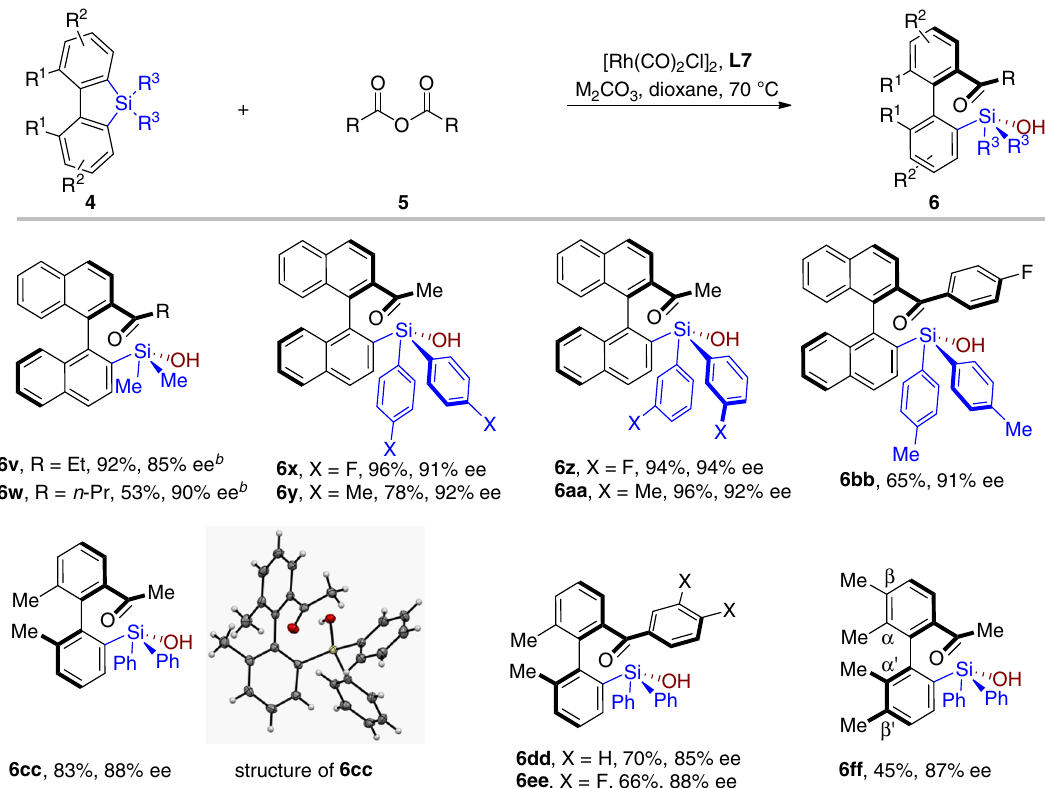
Fig. 4 Substrate scope a . a Reaction conditions: sila fl uorene 4 (0.20 mmol) and acid anhydride 5 (0.30 mmol, 1.5 equiv), [Rh(CO) 2 Cl] 2 (0.005 mmol, 2.5 mol%), L7 (0.021 mmol, 10.5 mol%) and base (30 mol%, Na 2 CO 3 for aliphatic anhydride, Cs 2 CO 3 for aromatic anhydride) in 1,4-dioxane (4.0 mL) at 70 °C for 24 h. b The reaction was performed with L1 as the ligand at 50 °C for 48